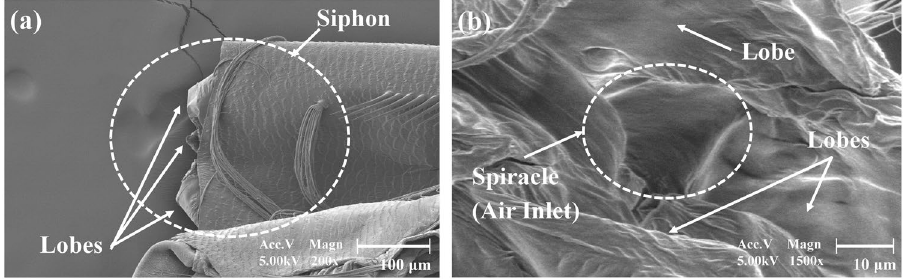
Figure 1. Typical SEM images of the siphon and lobes of Ae . togoi mosquito larva. SEM image of the siphon part (600X magnification) ( a ) and the spiracle part (1500X magnification) ( b ).